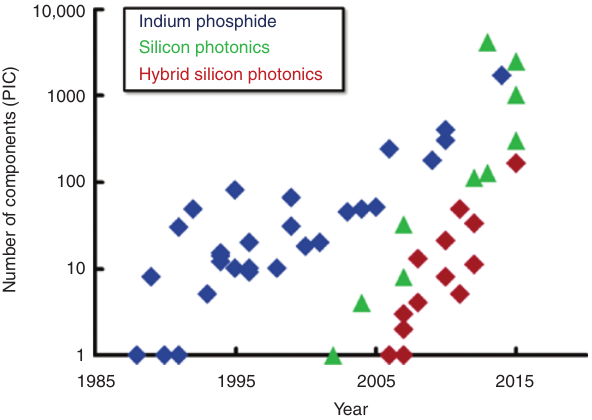
Figure 3: Evolution of the number of components on PICs over the last 30 years. Indium phosphide (blue), silicon photonic (green), and hybrid silicon (red) PICs are included. Figure was based on the data from Ref. [8] and expanded with some recent